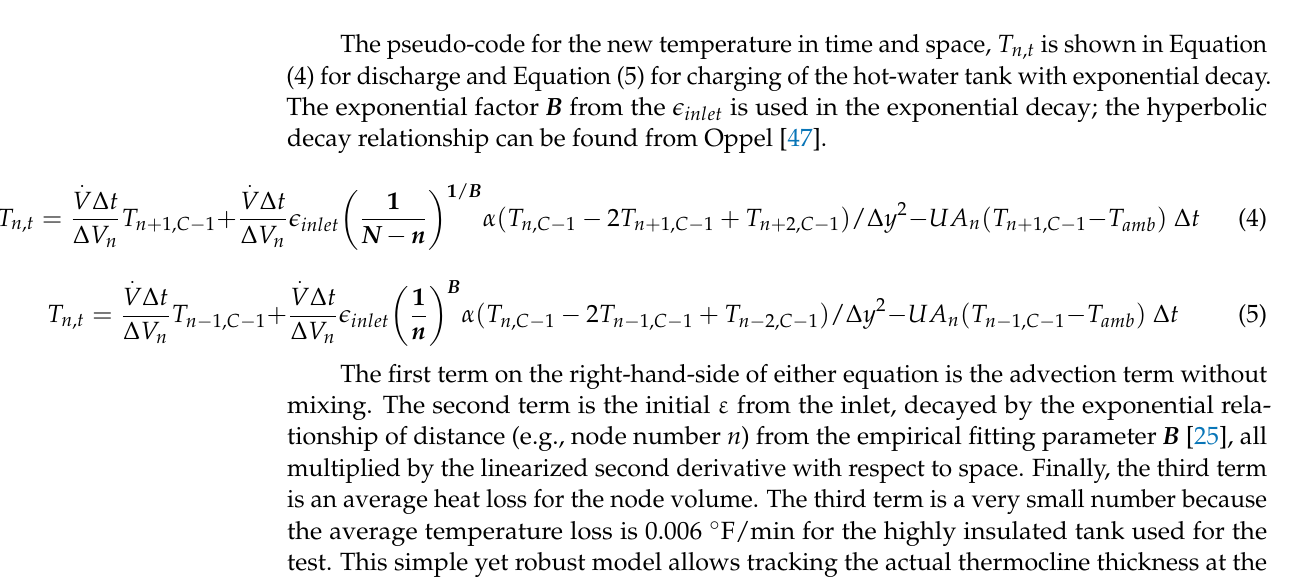
Figure 2. Computational flow diagram for discharge and charge of a stratified hot-water tank with empirical data for the relationship of (cid:2035) (cid:3036)(cid:3041)(cid:3039)(cid:3032)(cid:3047) and coefficients A and B .